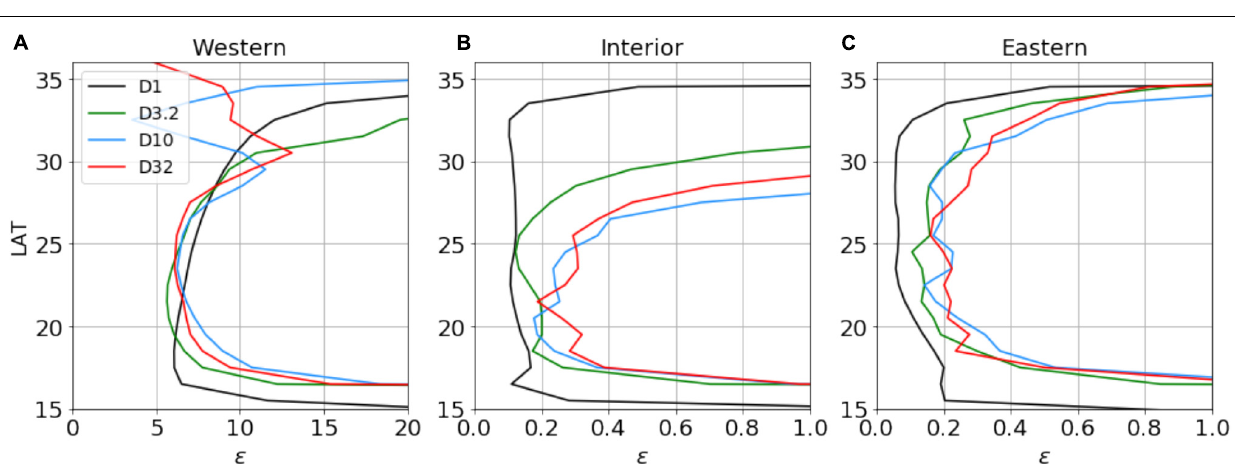
FIGURE 11 | Zonally averaged values of ε (Eq. 12) in the (A) western boundary (from 0 ◦ E to 10 ◦ E), (B) interior (from 10 ◦ E to 40 ◦ E), and (C) eastern boundary (from 40 ◦ E to 60 ◦ E) regions of the subtropical